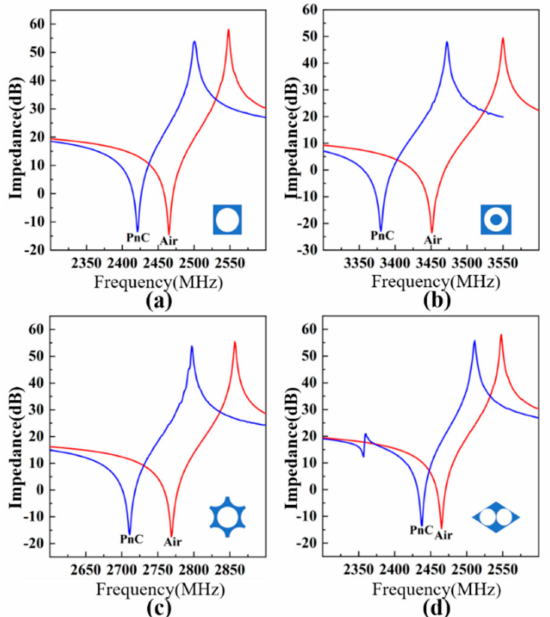
Figure 9. Comparison of impedance curves of the PhC-FBARs and Air-FBARs with the same piezoelectric stacks for the PhC structures of ( a ) square lattice, ( b ) square hollow cylinder lattice, ( c ) honeycomb lattice, and ( d ) triangular